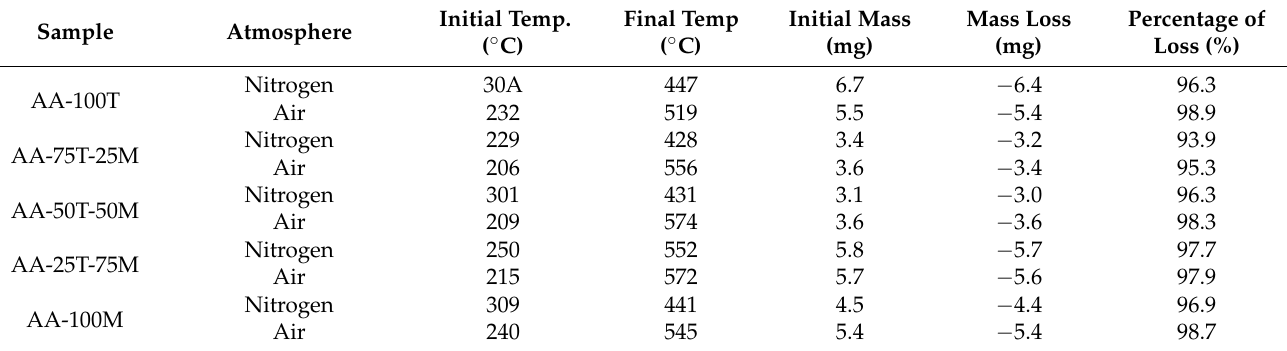
Table 5. TGA results for AA-100M; AA-75T-25; AA-50T-50M; AA-25T-75M; AA-100T.